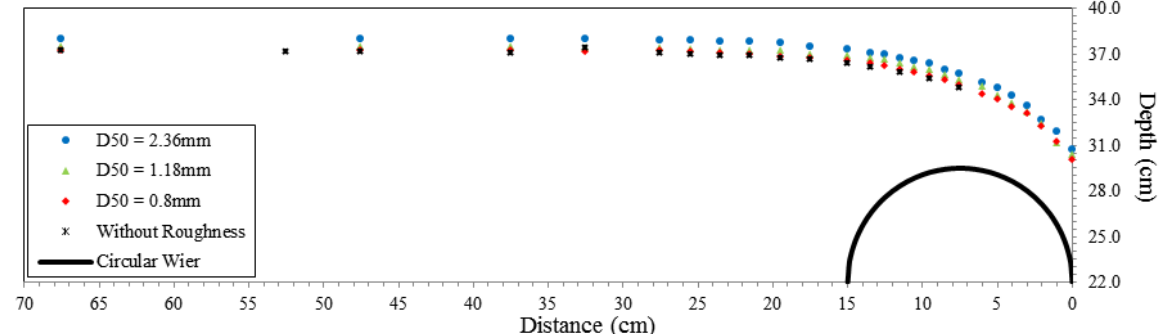
Fig. 4. Diagram of water surface profile over circular weir for different roughness sizes (Q = 14